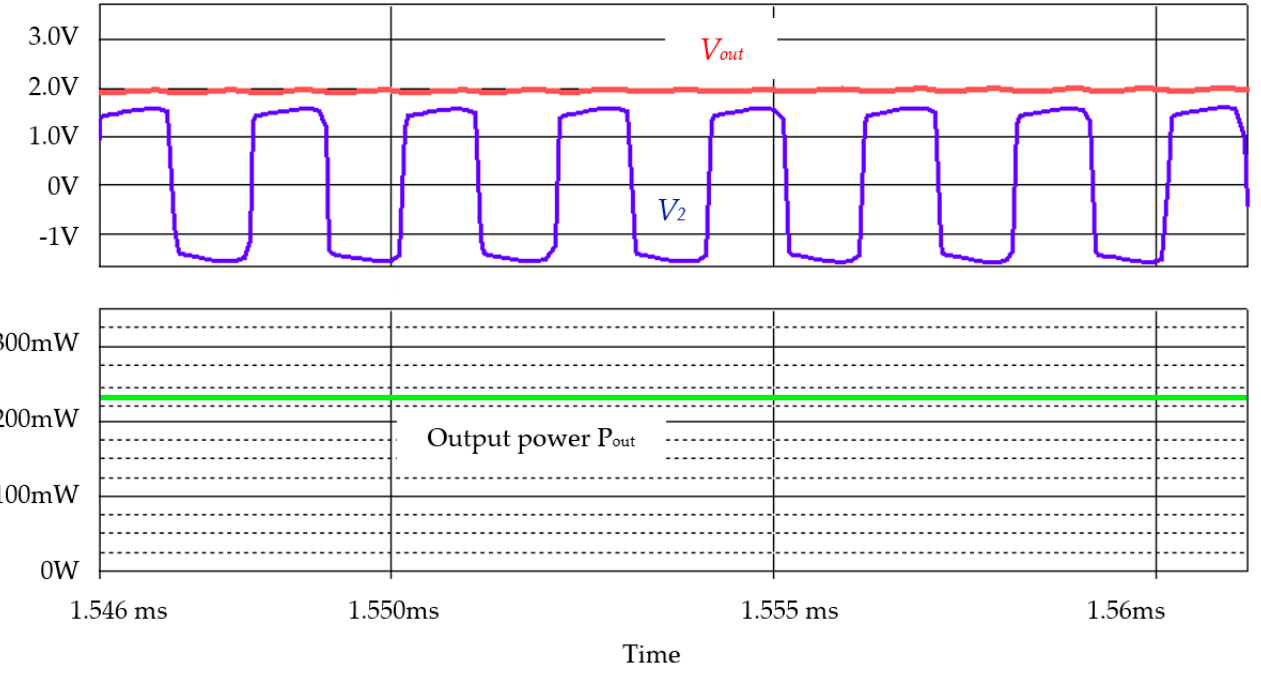
Figure 11. Waveform of the output voltage before the rectifier (blu), on the load (red) and the output power (green).